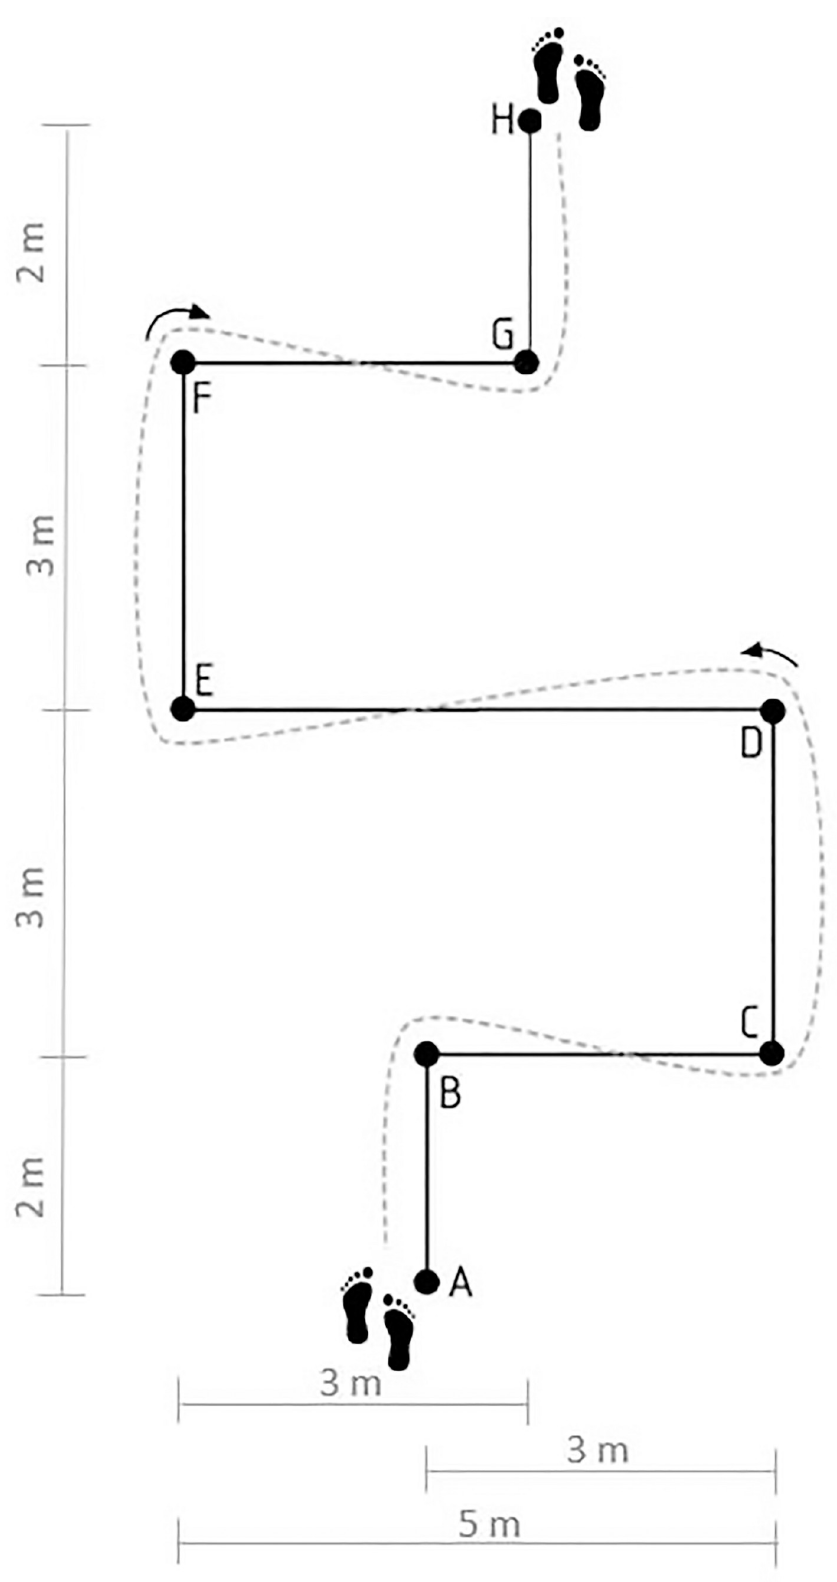
Fig 2. Scheme of the sprint with 90˚ turns